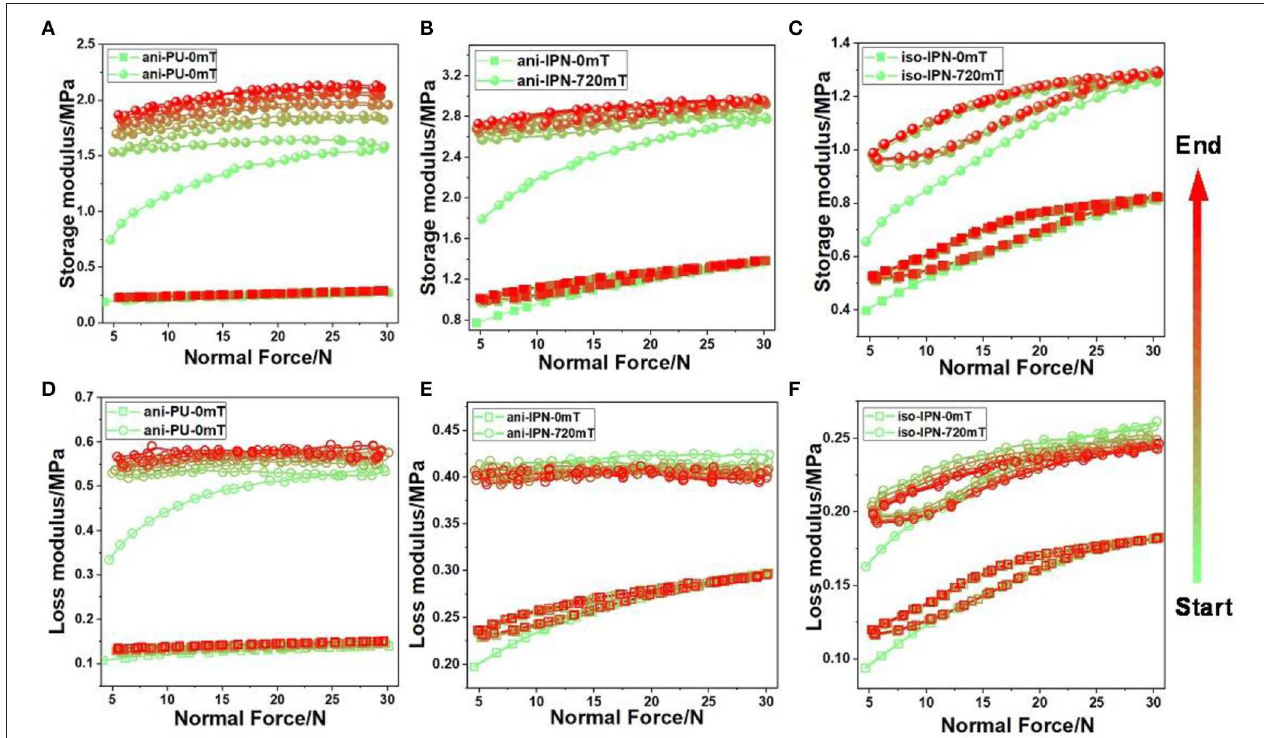
FIGURE 1 | The influence of the normal force on the dynamic viscoelastic properties of MRE samples. Dependence of storage modulus of ani-PU sample (A) , ani-IPN sample (B), and iso-IPN sample (C) on the normal force in the absence and presence of magnetic field. Dependence of loss modulus of ani-PU sample (D) , ani-IPN sample (E) , and iso-IPN sample (F) on the normal force in the absence and presence of magnetic field. The color scale indicates the progress of the cycle